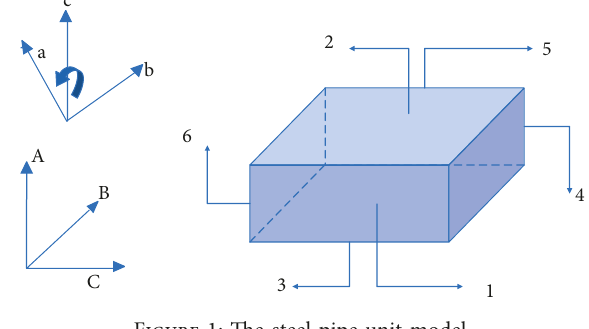
Figure 1: The steel pipe unit model.